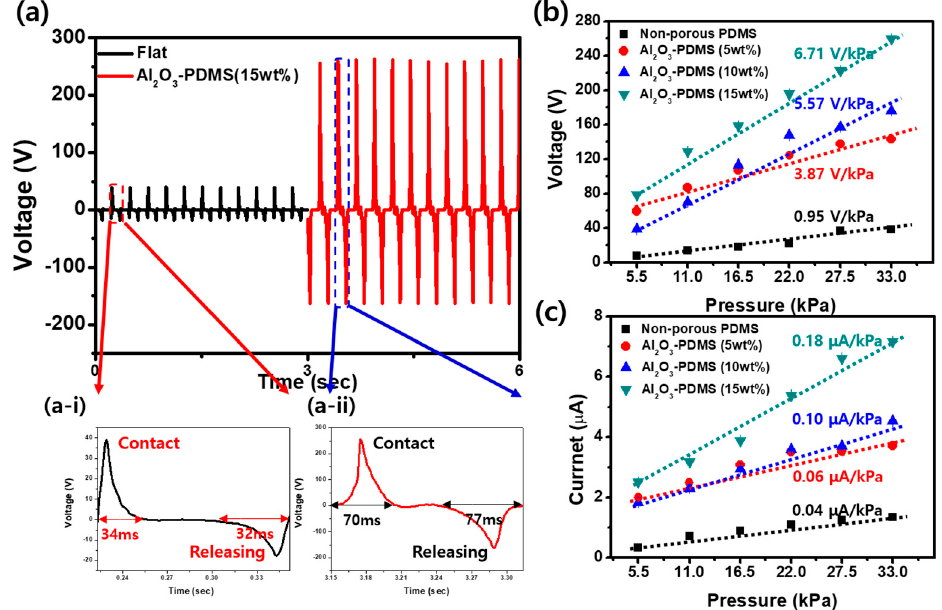
Figure 3. Performance comparison of non-porous PDMS and mesoporous Al 2 O 3 -PDMS (5, 10, 15 wt%). ( a ) The voltage comparison of non-porous PDMS and mesoporous Al 2 O 3 -PDMS at 30 N, 4 Hz and 3 × 3 cm 2 . The insets show a single peak of ( a-i ) PDMS and ( a-ii ) mesoporous Al 2 O 3 -PDMS (15 wt%). ( b ) The voltage and ( c ) current of mesoporous Al 2 O 3 -PDMS (5, 10, 15 wt%) with increasing pressure and the pressure sensitivity.